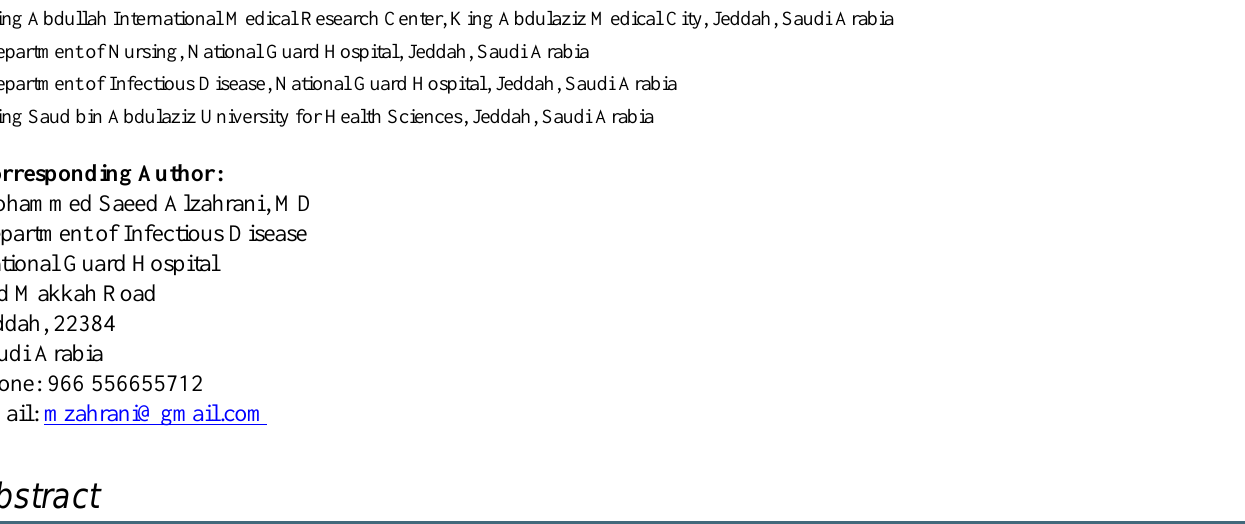
COVID-19; health care workers; infection control; attitude; knowledge; Saudi